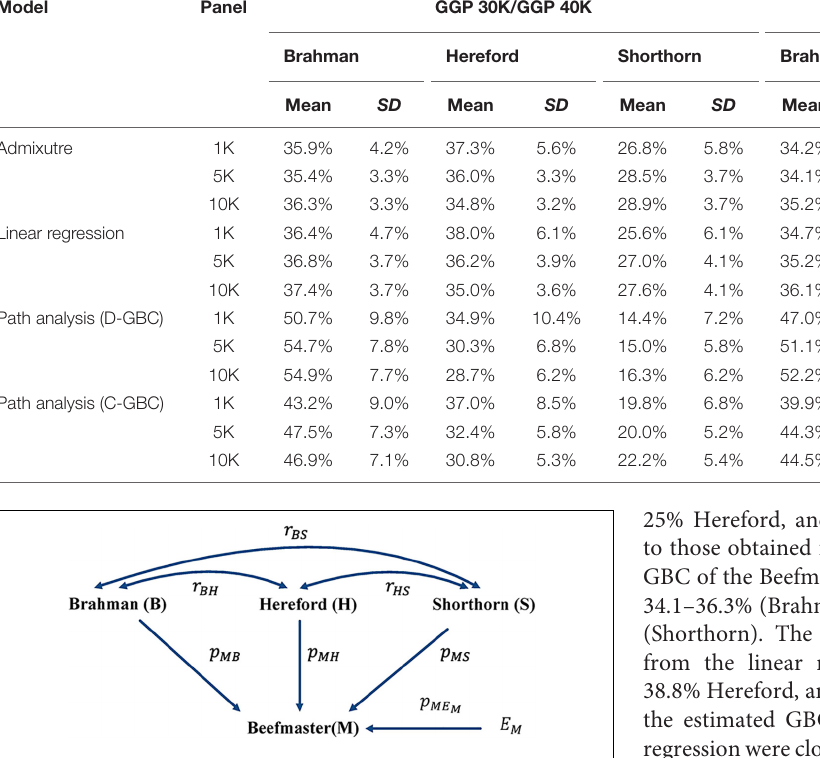
FIGURE 3 | Path diagram of the relationships between Beefmaster and three ancestral breeds, namely Brahman, Hereford, and Shorthorn. p yx = path coefficient from x to y ; r xy = correlation between x and y